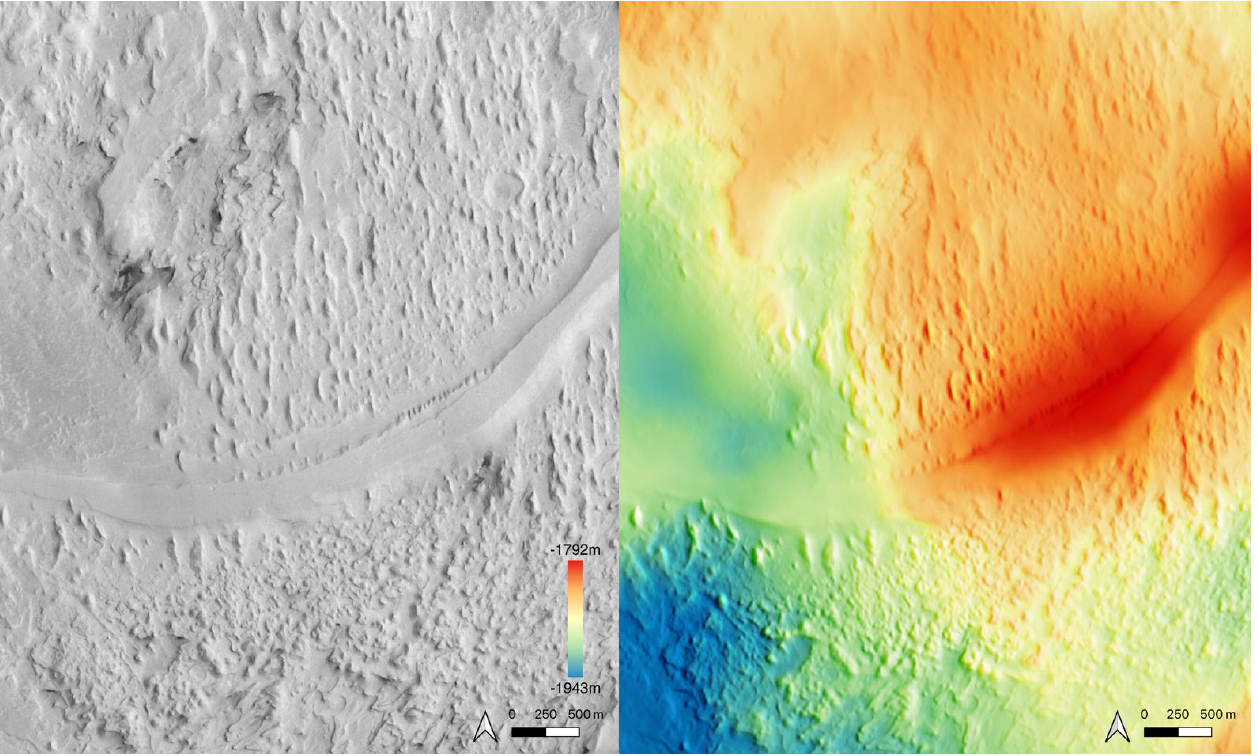
Figure 12. A crop of the 4 m/pixel CaSSIS image and 8 m/pixel MADNet CaSSIS DTM (colourised and hillshaded using similar solar angle as the image) over site-2, showing Yardangs running north-south and an inverted channel curving from west to east. To look into details—please refer to the full-resolution figures provided in Supplementary Materials.